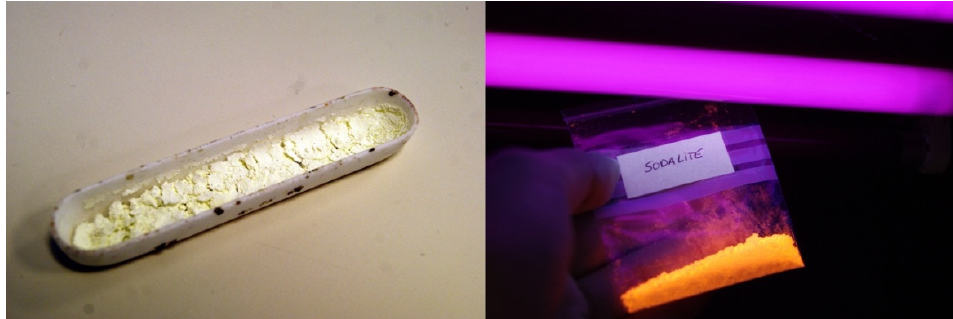
Figure 3. Aspect of sulphur sodalite zeolite composite after synthesis under visible light ( left ). Aspect of sulphur sodalite zeolite composite powder under 366 nm UV lighting ( right ). Author’s photos. Figure created by author.